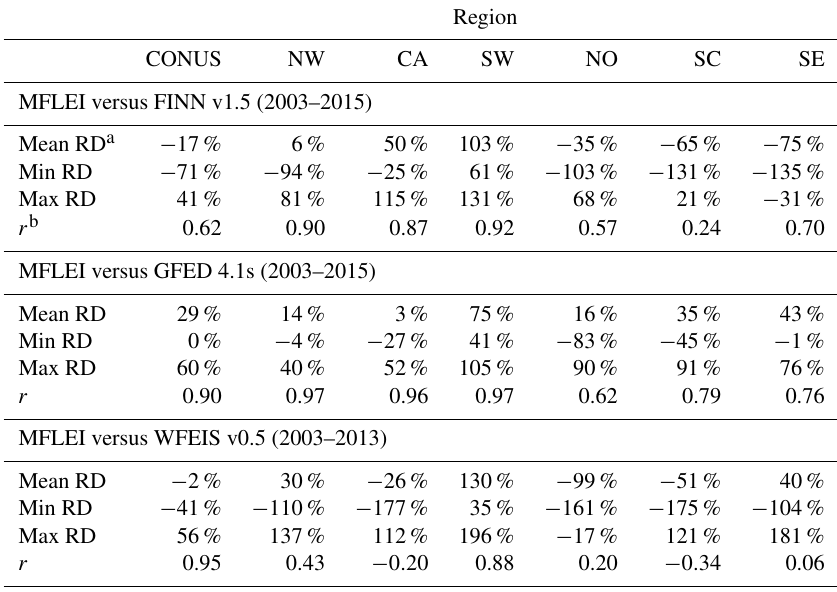
Table 11. Statistics for comparison of annual fuel consumption by region between MFLEI and FINN v1.5, GFED v4.1s, and WFEIS v0.5. Regions are as defined in Fig. 14a.